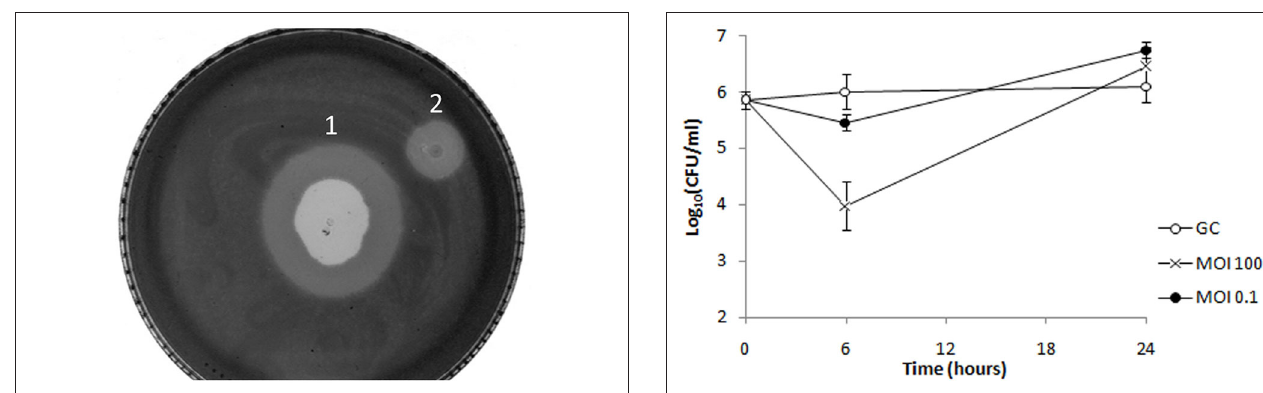
the sixth hour after treatment suggests that phages are active on biofilm-embedded cells.